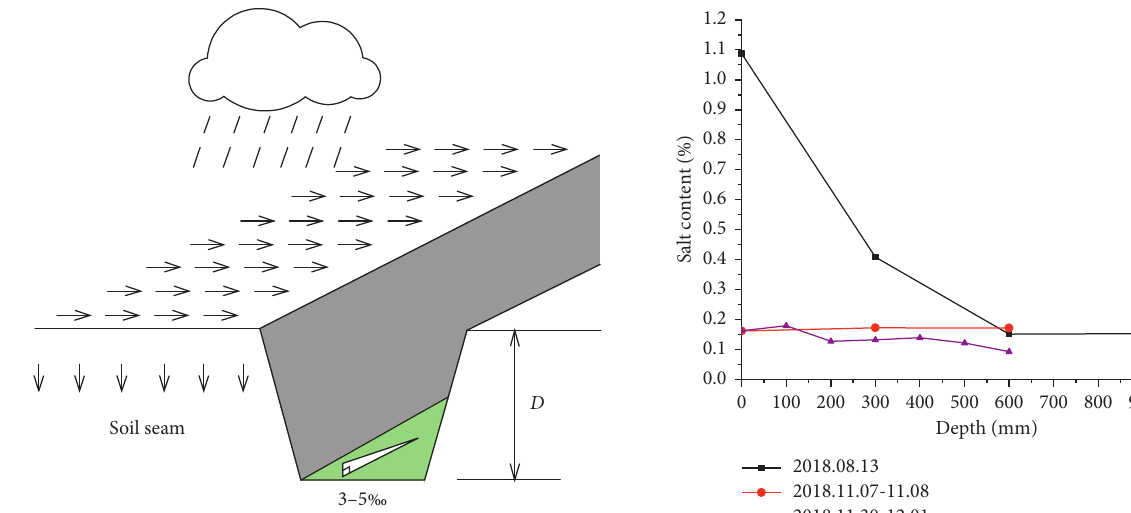
Figure 3: Sketch of the salt-discharging engineering model.